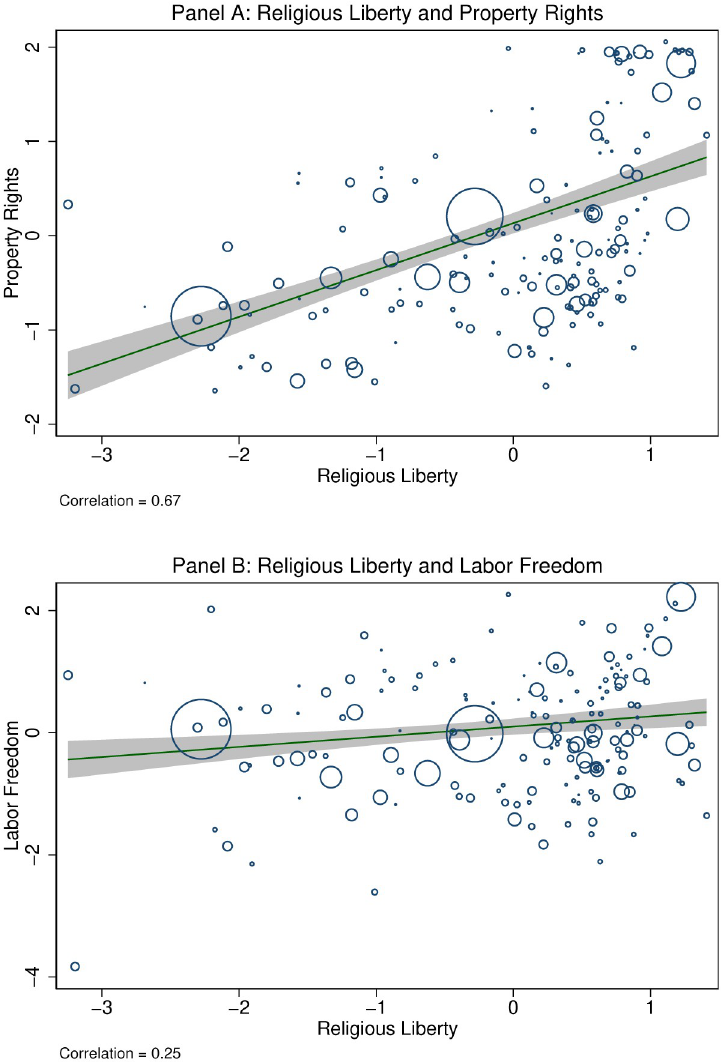
Fig 3. Religious liberty and heritage index of economic freedom correlations. Sources: Varieties of Democracy and Heritage Foundation. The figure plots the population-weighted relationship between standard normal measures of religious liberty and institutional quality measured with property rights and labor market freedom. These indices are standardized based on their 1995-2018 average.